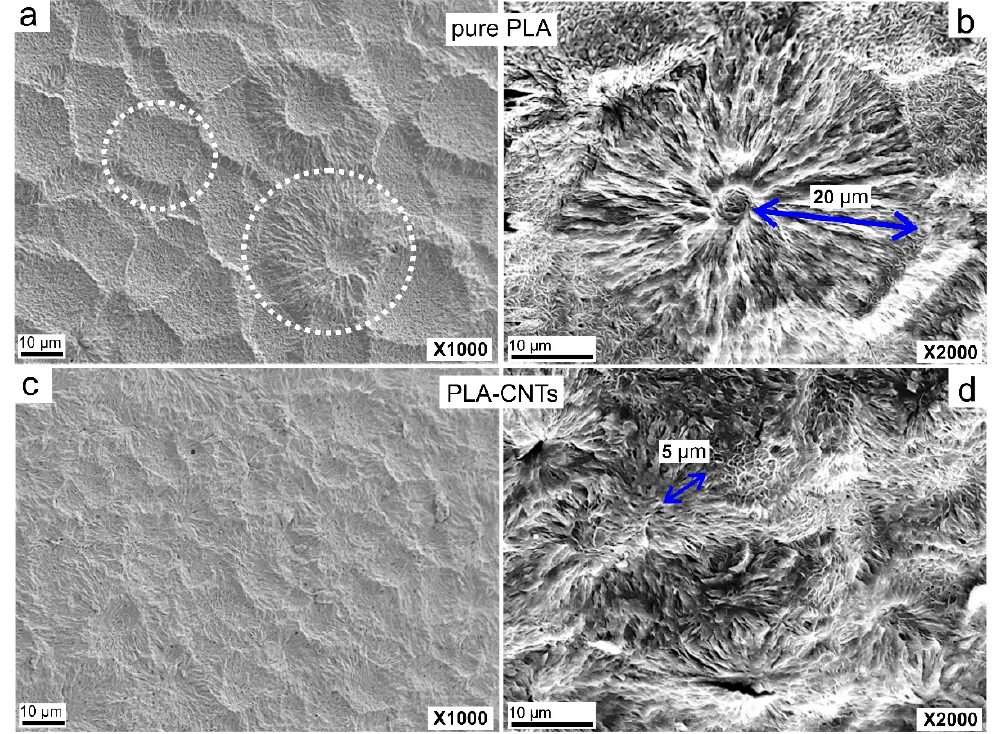
Figure 3. Scanning electron micrographs at 1000× and 2000× magnification of pure PLA ( a , b ), and PLA-CNT ( c , d ) after isothermal crystallization.